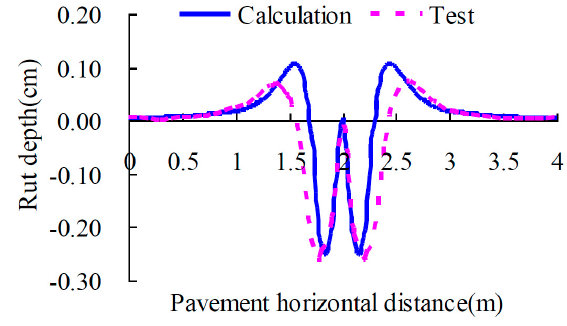
Figure 7. Aggregate gradations of the asphalt mixtures.